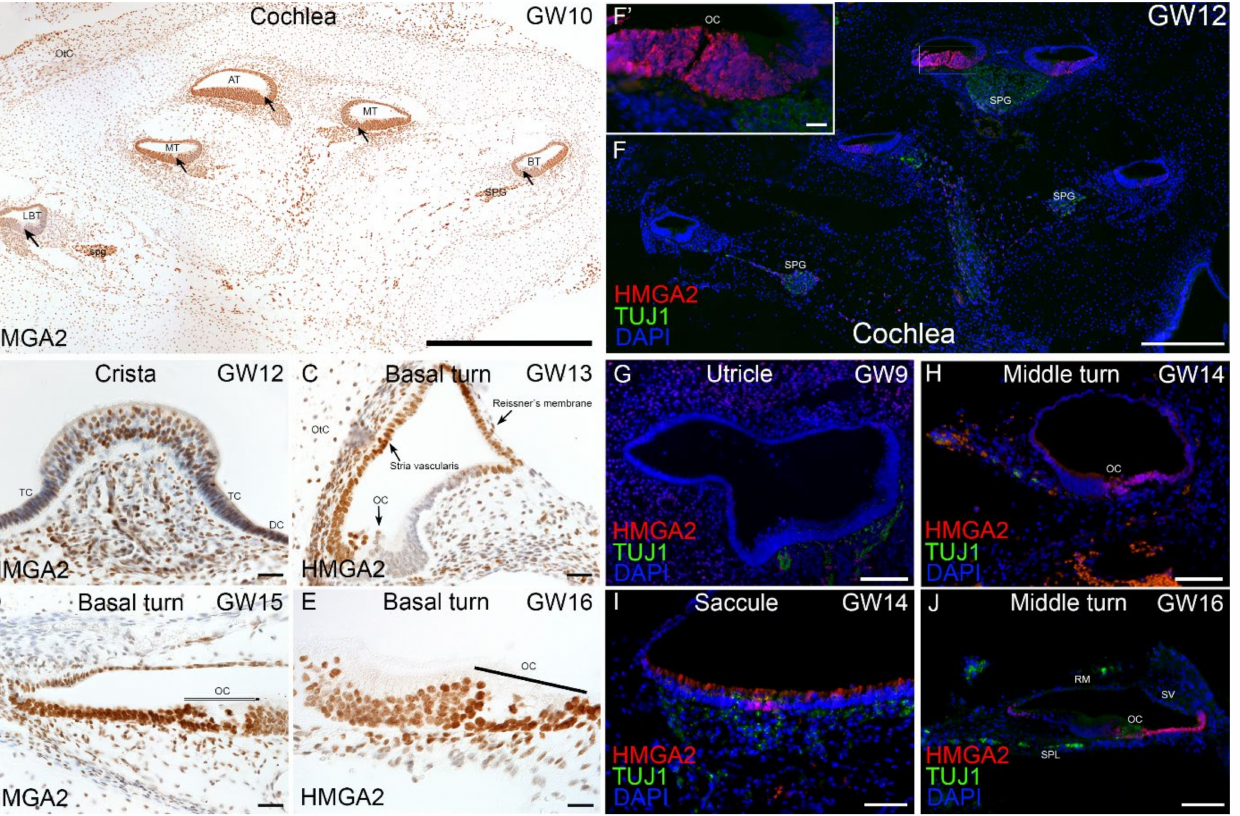
Figure 8. Immunostaining for HMGA2 in human inner ear fetal tissue. ( A ) Overview of immunostained cochlea at GW10. Intense immunostaining for this marker present at middle turn (MT), basal turn (BT) and apical turn (AT) of cochlea as well as in spiral ganglion (SPG). A moderate immunoreaction observed at lower basal turn (LBT). Organ of Corti (arrows). ( B ) Crista ampullaris at GW12. Lowered immunoreactivity with intense expression amongst supporting cells of the crista. Transition cells, TC; dark cells, DC. ( C ) Basal turn of cochlea at GW13. HMGA2 immunostaining is restricted to select regions including future stria vascularis, Reissner’s membrane and nerve fibers. Supporting cells and future organ of Corti (OC) are devoid of immunoreactivity. A few cells of spiral ligament and chondrocytes of otic capsule (OtC) are still immuno+. ( D ) Basal turn of cochlea at GW15. Immunostaining is evident in all supporting cells, the future cells of